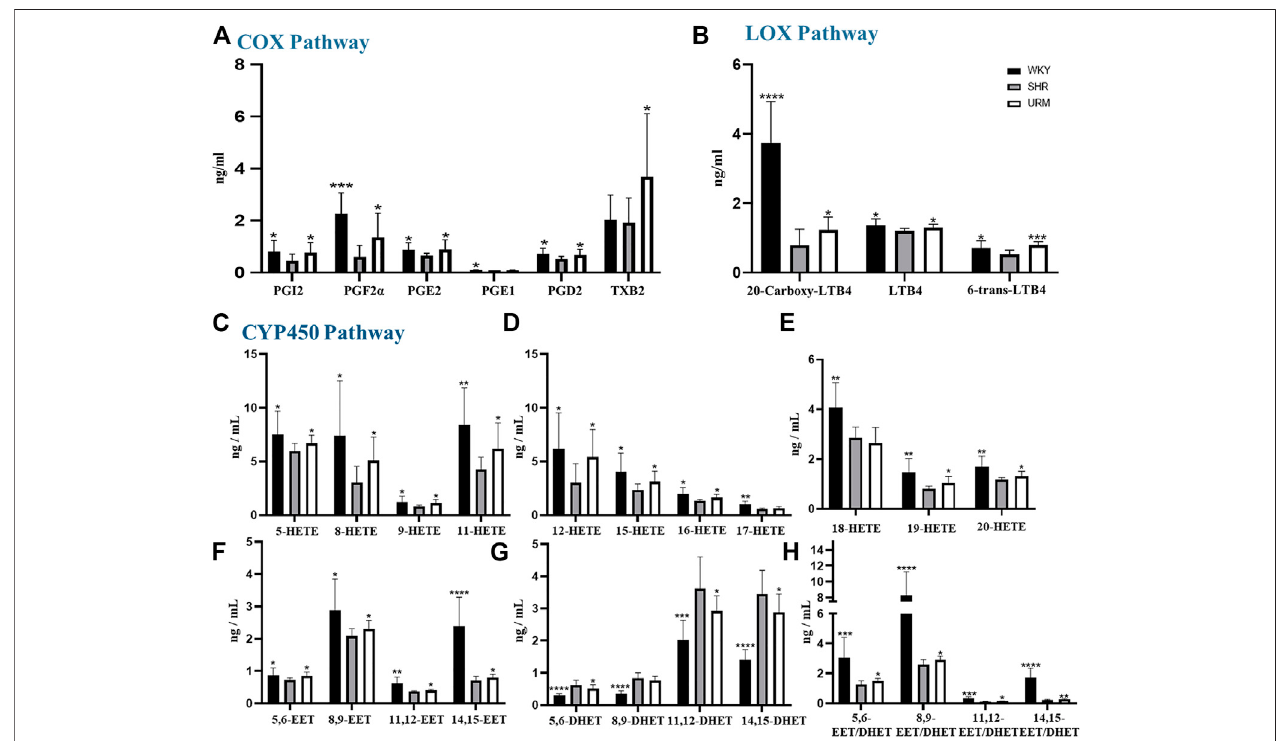
FIGURE 3 | Effects of URE on arachidonic acid metabolites concentrations in plasma of spontaneously hypertensive rats. (A) were the concentrations of PGs, PGI2,andTXsintheplasmaofdifferentgroupsofrats, (B) weretheconcentrationsofLTs; (C – E) weretheconcentrationsofHETEs. (F) and (G) weretheconcentrations of EETs and DHETs, and (H) were the EET/DHET ratios. Values are mean ± SD ( n = 8). p p < 0.05, pp p < 0.01, ppp p < 0.001, pppp p < 0.0001 vs.